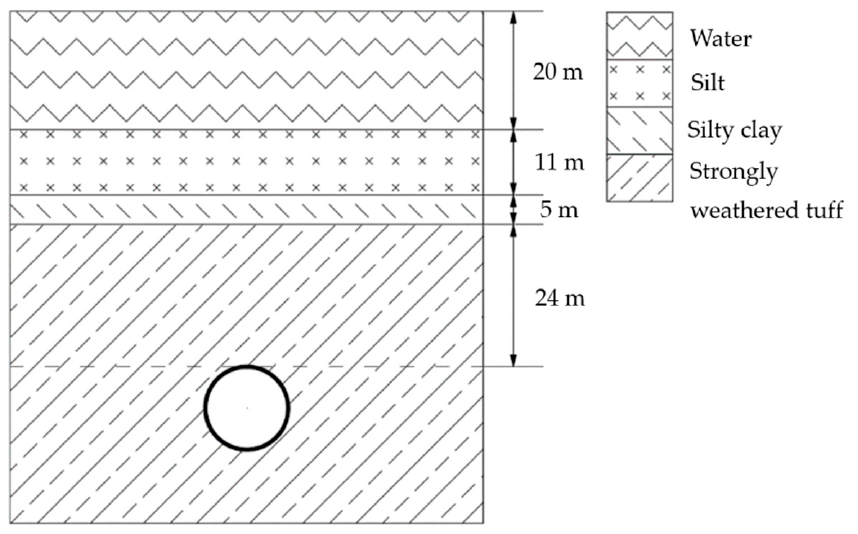
Figure 8. Schematic diagram of stratum section. Table 2. Formation parameters.